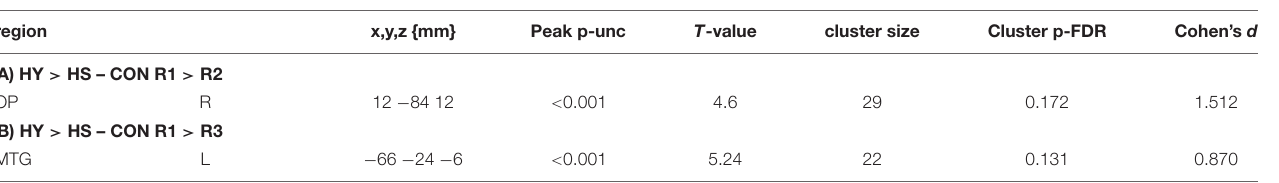
TABLE 5 | Interaction analyses with factors session and group for CON RS activity. region